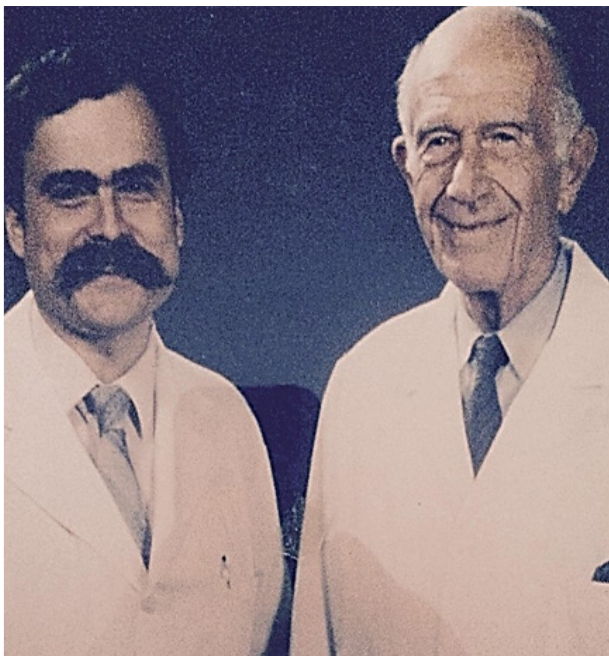
Fig. 7 - Drs. Tomas Salerno and Arthur Vineberg who developed the procedure of direct implantation of the internal mammary artery into the left ventricle for the relief of myocardial